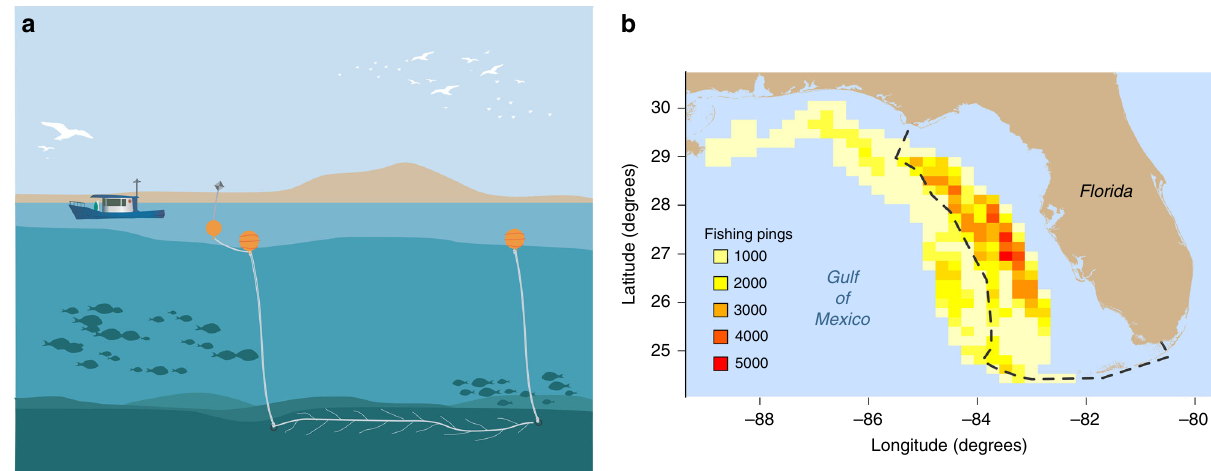
Fig. 1 Longline fi shing in the Gulf of Mexico. a Bottom longlines are one of the primary gears used to catch commercially important grouper and tile fi sh. The longline consists of a line of baited hooks deployed along the seabed in reef areas of the Gulf, which remains in position for a number of hours before being recovered, at which point the fi sh are removed, the hooks are rebaited and the line is redeployed. b Heat map of fi shing activity by longline vessels in the eastern Gulf of Mexico during the 2-year period prior to an emergency closure from May to October 2009. Higher fi shing activity (darker shading) cells mostly lie within the boundary of the subsequently closed area (dashed line), highlighting the magnitude of the disturbance when many vessels were forced to relinquish their most- utilized fi shing grounds. To maintain data con fi dentiality, locations fi shed by fewer than three vessels are not